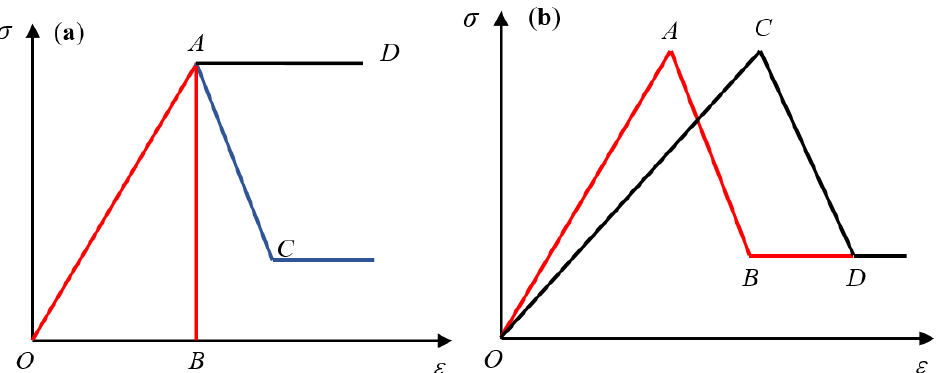
Figure 6. Simplified stress-strain curves of several typical rocks ( a ) The stress-strain curves before the peak stress are the same but different after the peak stress ( b ) The stress-strain curves before the peak stress are different but the same after the peak stress.